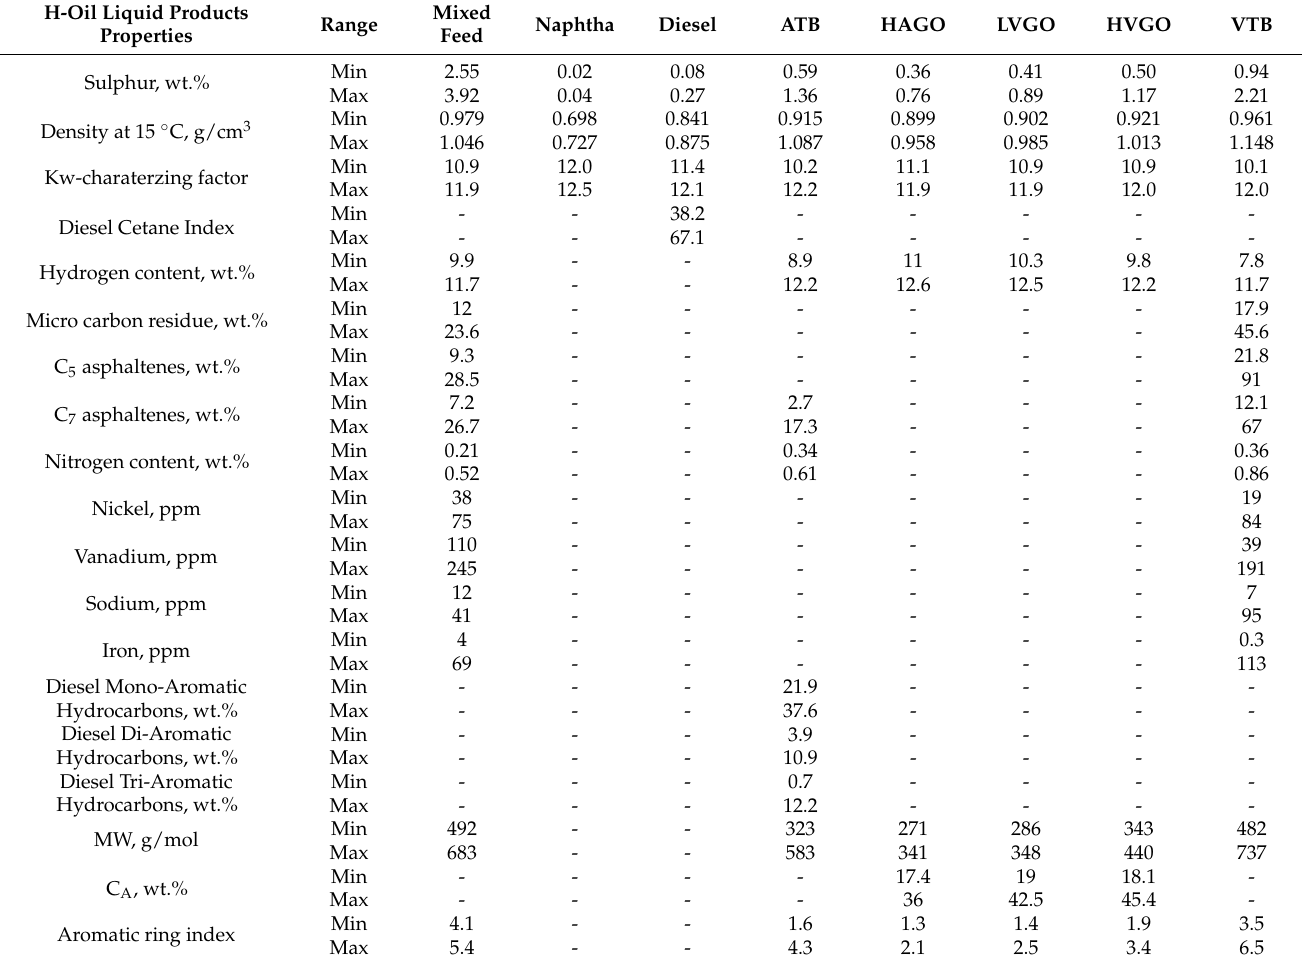
Table 2. Variation in the properties of liquid H-Oil ® EBVRHC